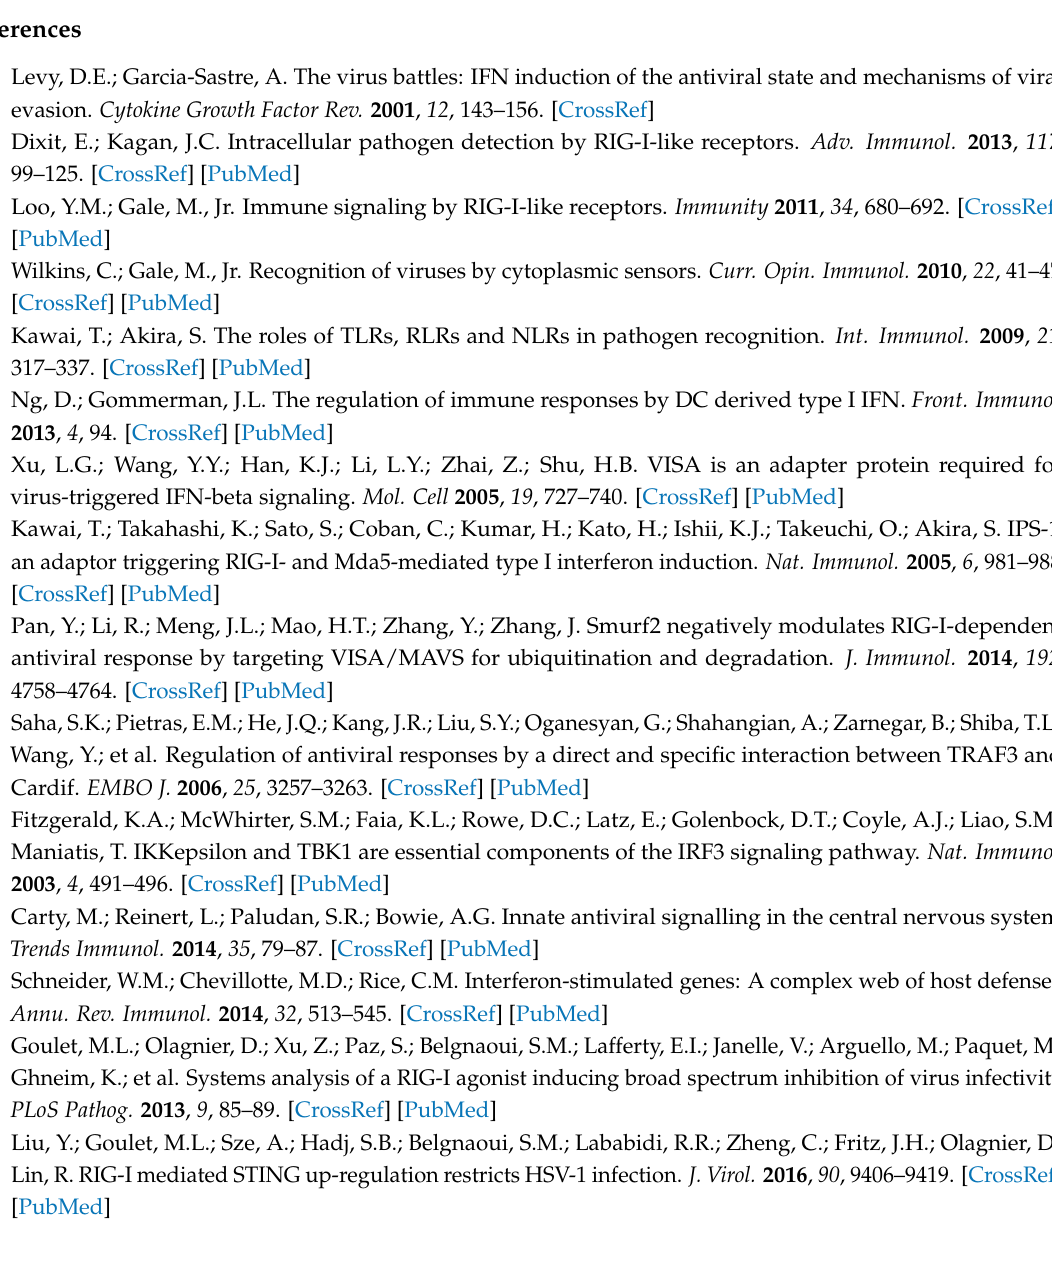
Figure S1: The effect of NOP53 on HSV-1 replication is independent of PTEN, Figure S2: NOP53 did not affect autophagy and apoptosis induced by HSV-1